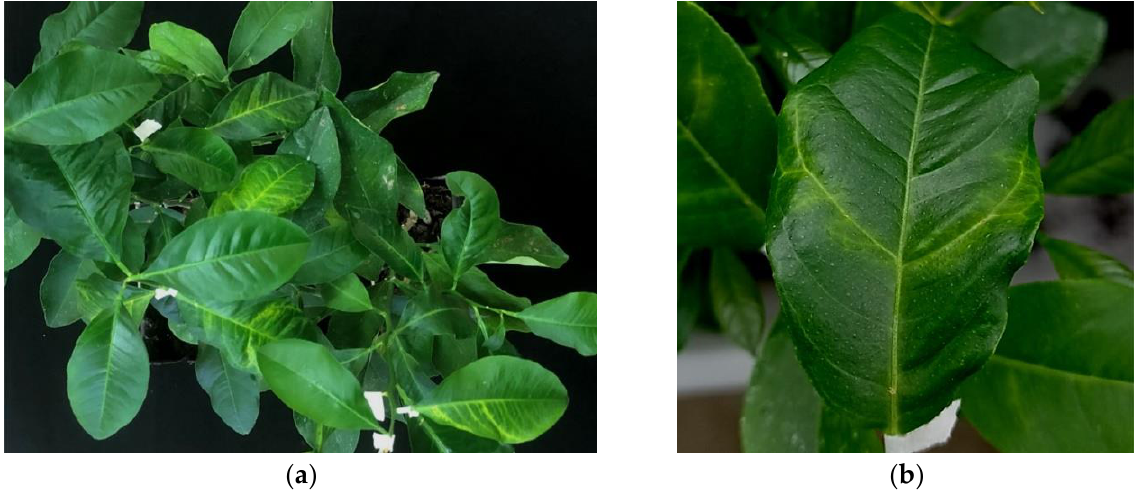
Figure 5. ( a ) Mal secco disease symptoms on artificially inoculated plants; ( b ) detail of leaf veins chlorosis.